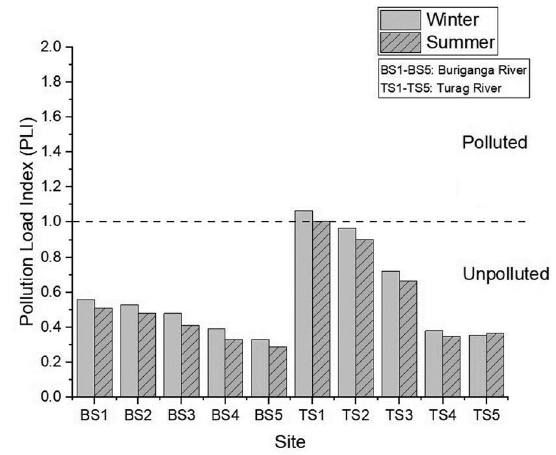
Fig. 2 Contamination factor (CF) of heavy metals in sediment of two studied Rivers Fig. 3 Pollution load index (PLI) of heavy metals in sediment of two studied